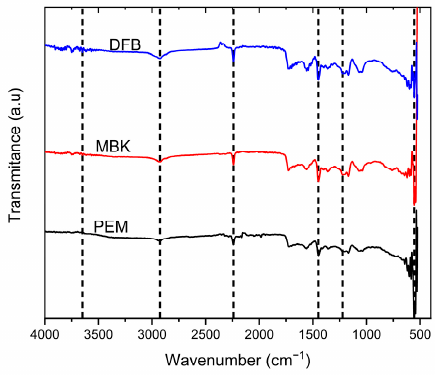
Figure 4. ATR FTIR Spectra of untreated Douglas fir biochar (DFB), DFB treated with MgCl 2 · 6H 2 O + KOH solutions (MKB), and MBK treated with KH 2 PO 4 solution (PEM).